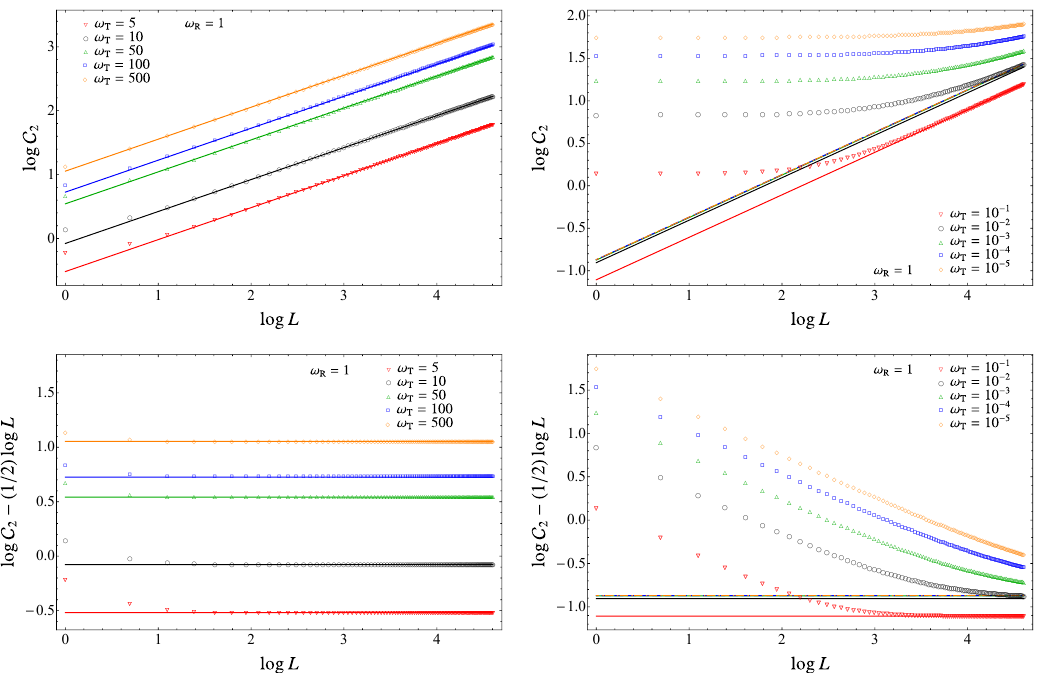
Figure 4 . The complexity C 2 in terms of the size L of the periodic harmonic chain. The reference and the target states are the ground states with ω = ω and ω = ω respectively (here κ = m = 1 ). R T The data reported correspond to ω = 1 and different ω . The solid lines in the top panels R T represent (9.27), while the horizontal solid lines in the bottom panels correspond to the constant values of a (˜ ω , ˜ ω ) obtained from T R